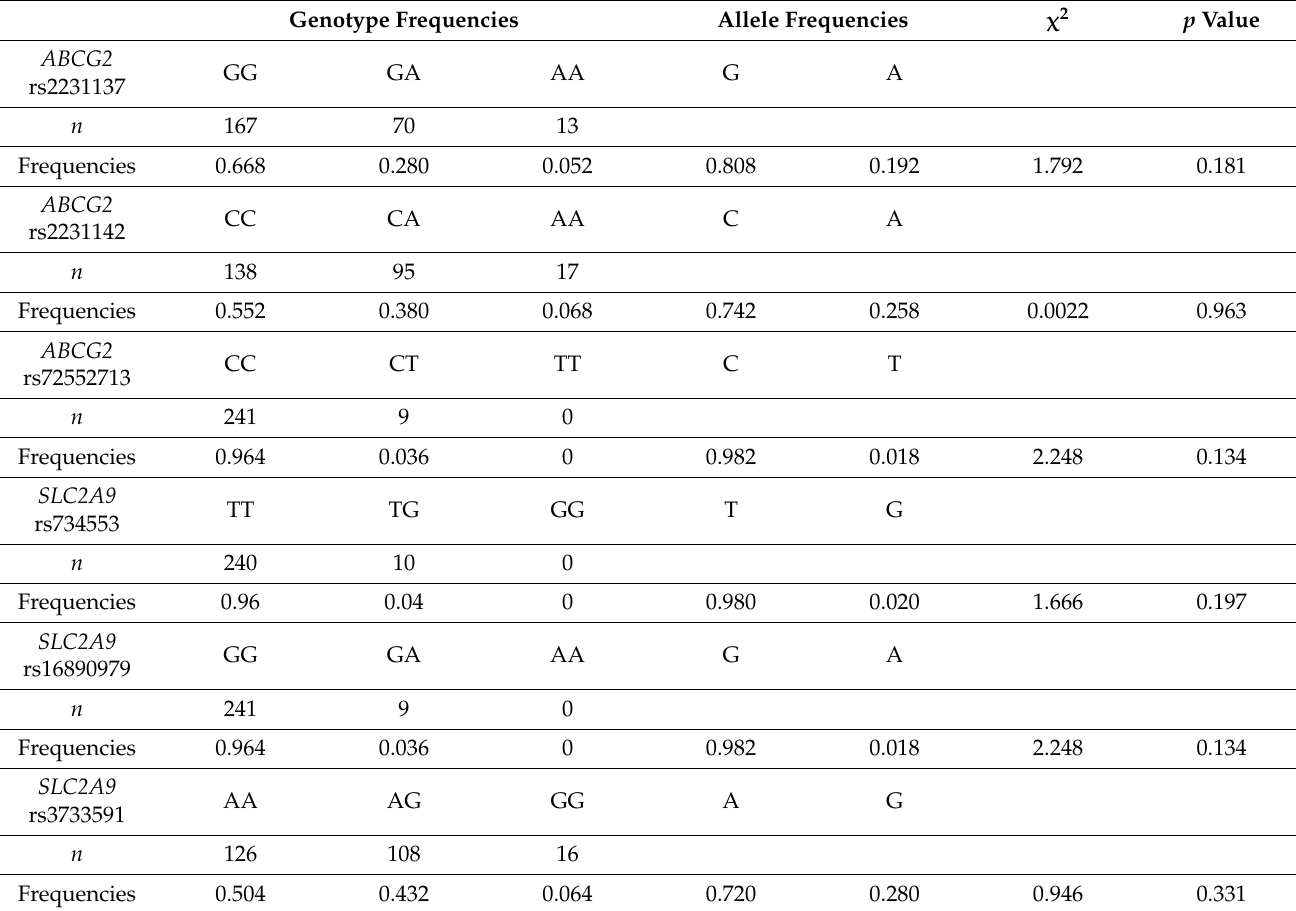
Table 2. Genotypes of the participants and allele frequencies for the ABCG2 and SLC2A9 polymor-